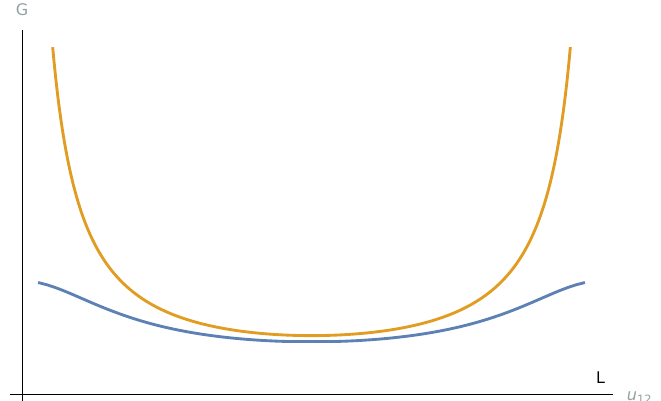
Figure 13 . The two-point function in the small (cid:15) approximation (yellow) versus the precise one